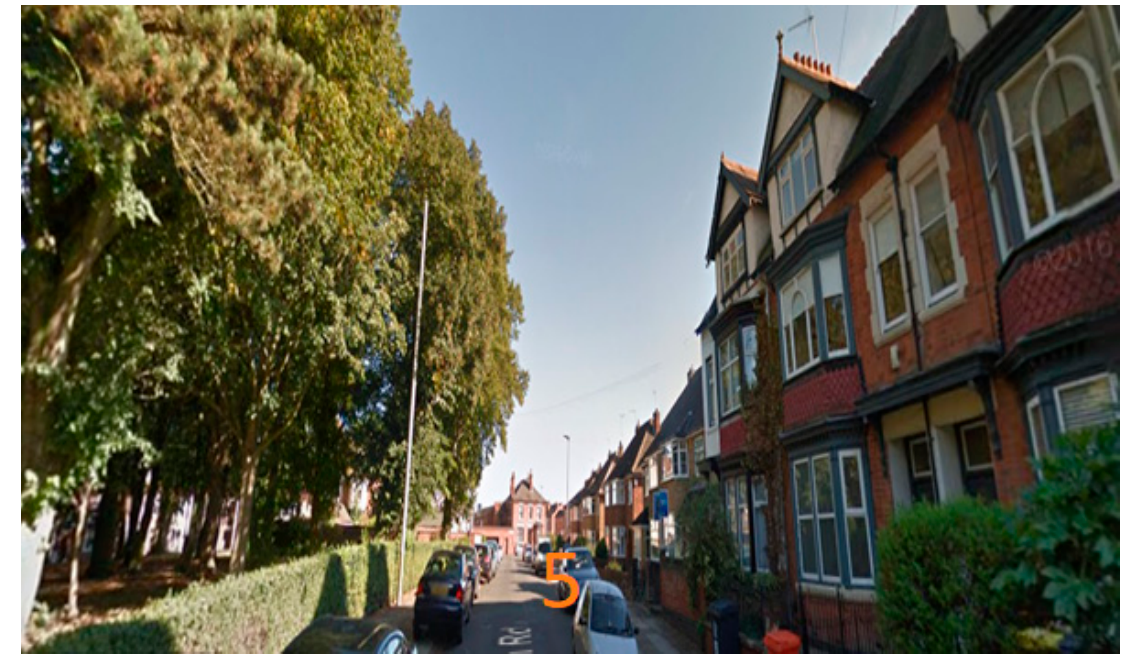
Figure A3. Location 3 (Map data ©2017 Google).